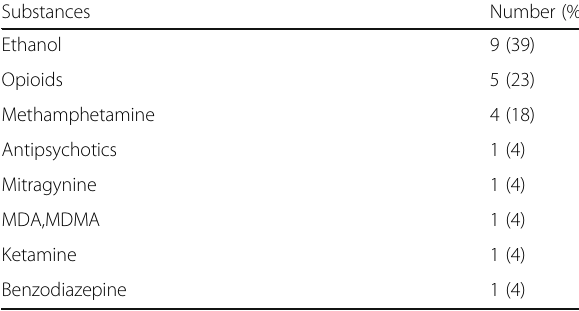
Table 5 Percentages of common substances in study